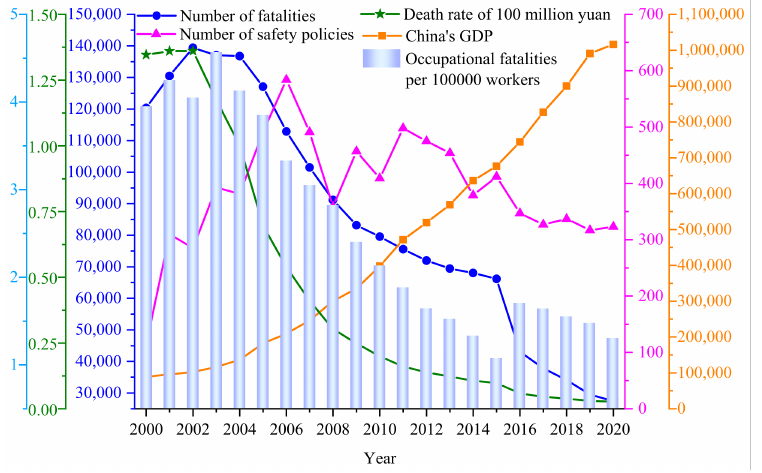
Figure 1. Changes in the number of safety policies in China and in work-related